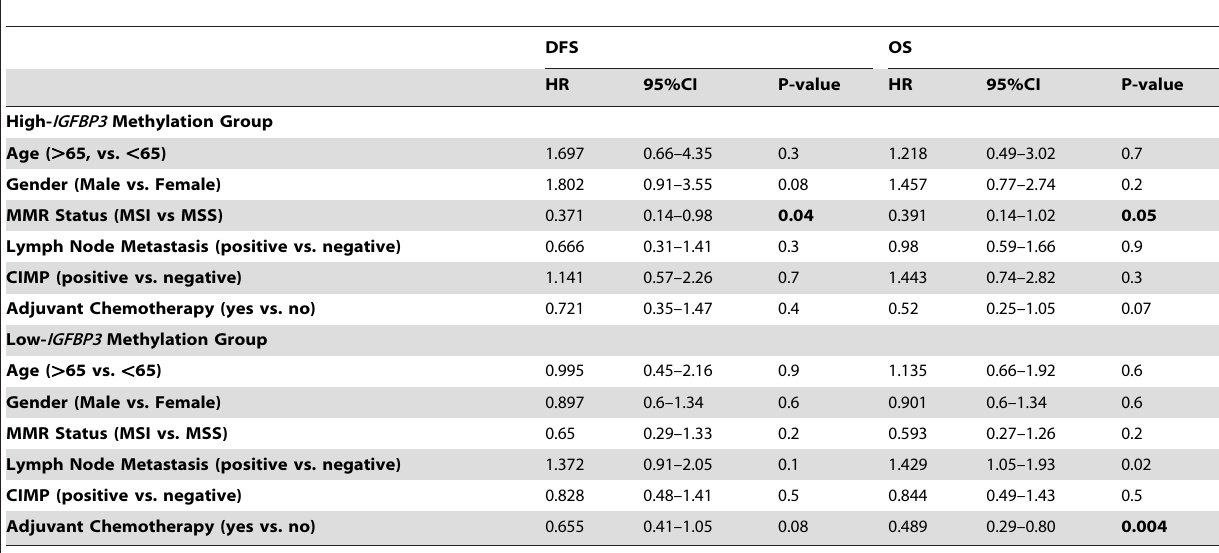
Table 4. Multivariate analysis of disease-free survival and overall survival in stage ii and iii crc patients and igfbp3 promoter methylation